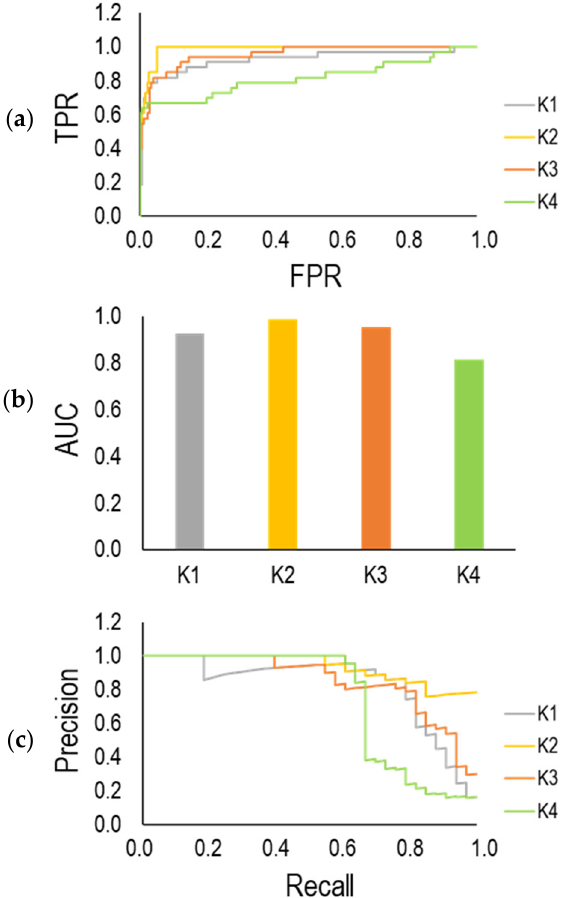
Figure 16. ( a ) ROC curve; ( b ) AUC (area under the ROC curve); ( c ) precision-recall